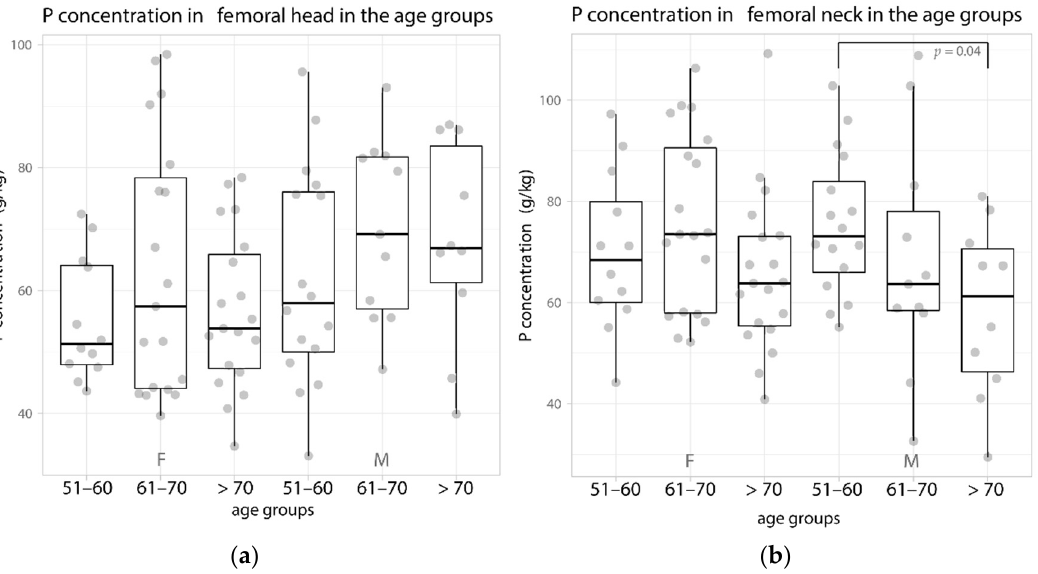
Figure 2. Data distribution (jittered dots) and boxplot of the median P content (in g/kg) in the age groups in women and men in the femoral ( a ) head and ( b ) neck. F—female, M—male.